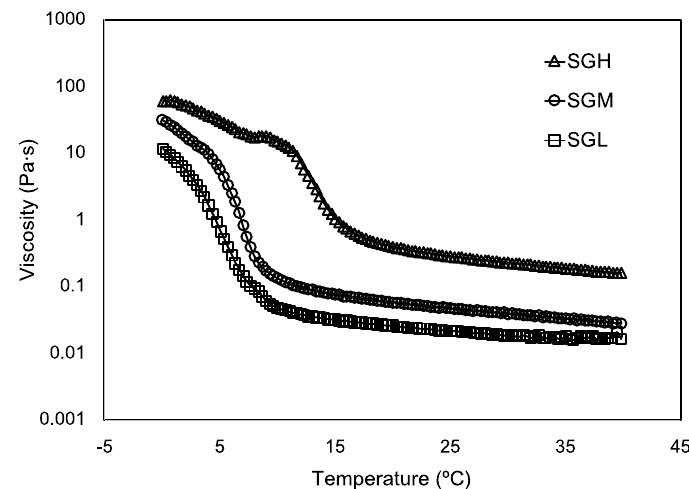
Figure 4. Flow temperature sweep of SG samples with controlled molecular weight.